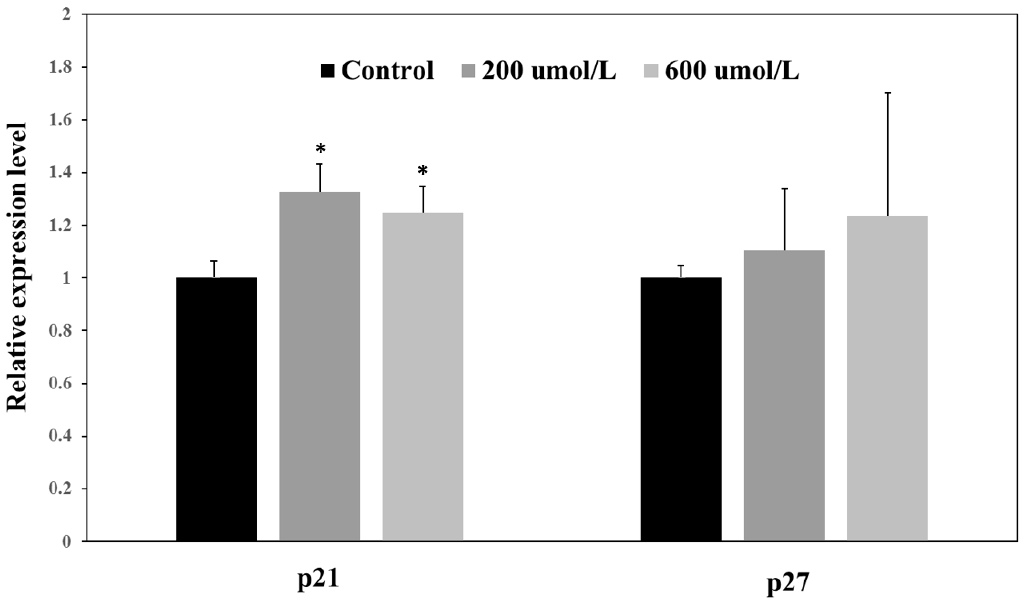
Figure 2. Relative expression levels of cyclin kinase inhibitor p21 and p27 in control, 200 and 600 μ mol·L -1 treatment groups. * Significant difference between each treatment and control in each cyclin 600 µ mol · L − 1 treatment groups. * Significant di ff erence between each treatment and control in each kinase inhibitor at p < 0.05. cyclin kinase inhibitor at p <